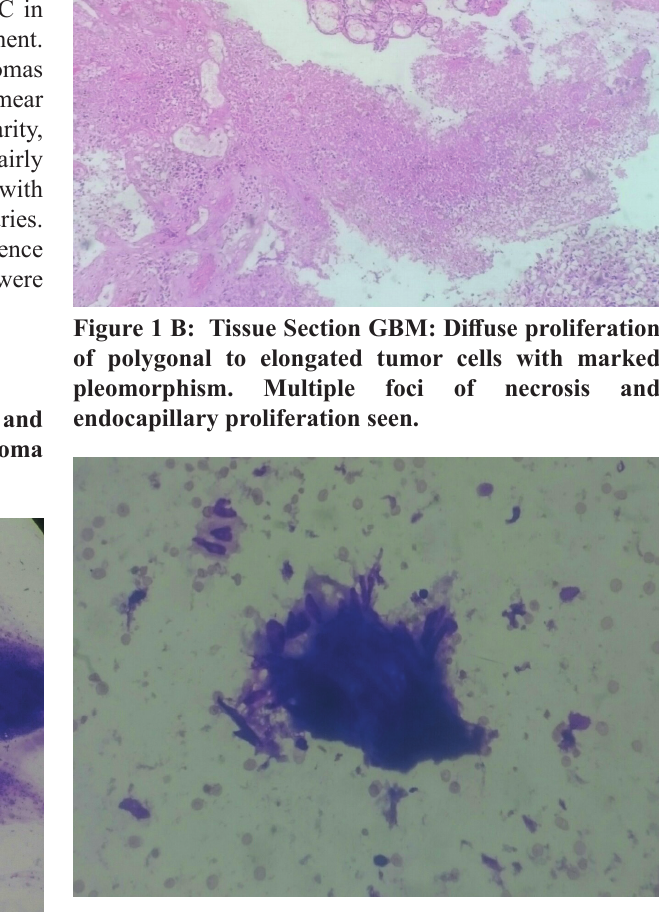
Figure 2A and 2B: Squash Cytology and Histopathological Examination of Transitional